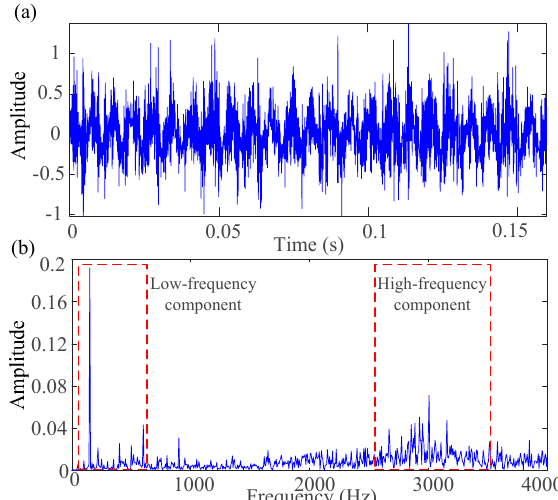
Figure 1. ( a ) The waveform of measured rating machinery vibration signals, and ( b ) its corresponding frequency spectrum.